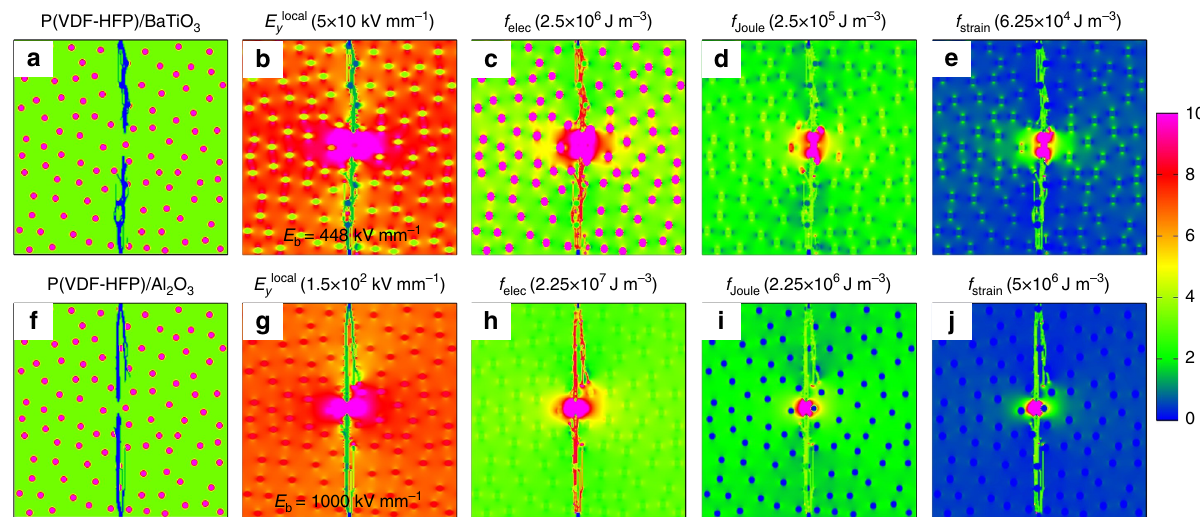
Fig. 7 Breakdown morphologies of polymer nanocomposites from phase- fi eld simulations. The fi nal state of the breakdown process of a BaTiO 3 /P(VDF- HFP) nanocomposite and ( f ) Al 2 O 3 /P(VDF-HFP) nanocomposite with corresponding electric- fi eld distributions shown in b , g , electric energy density distributions shown in c , h , Joule heat energy density distributions shown in d , i , and strain energy density distributions shown in e ,